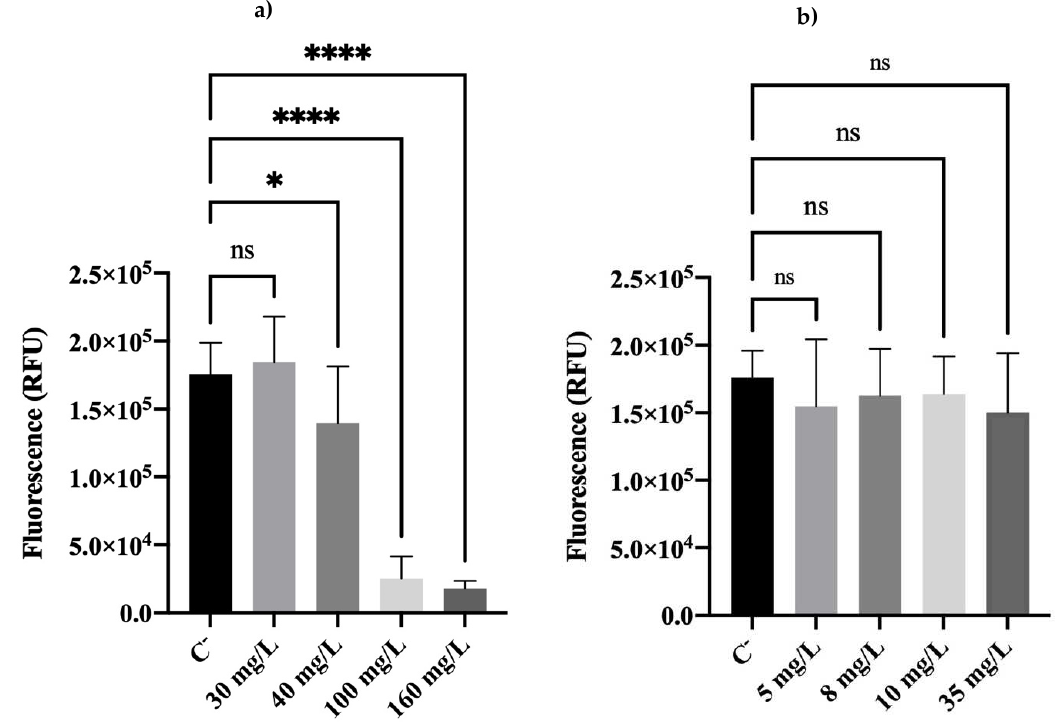
Figure 3. Fluorescence of Pseudomonas fluorescens cells stained with resazurin after an overnight step in a nutrient medium, resulting from previous exposure to different concentrations of ( a ) BAC and ( b ) DBNPA for 30 min. Controls were performed with untreated cells (C − ). The means ± SD of three independent experiments are presented. ‘ns’ indicates not significant ( p > 0.05), whereas the asterisks indicate statistical significance (* p < 0.05 and **** p < 0.0001), using Tukey’s multiple comparison test. RFU: relative fluorescence units .